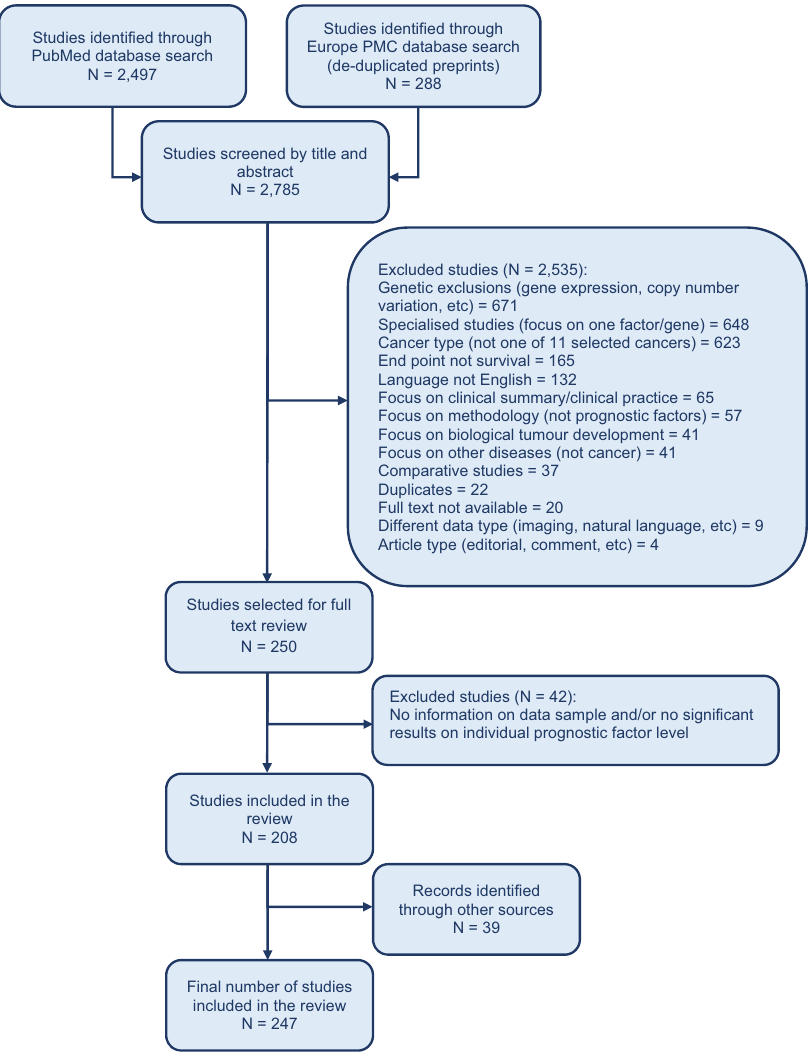
Fig. 1 PRISMA fl ow diagram of study inclusions and